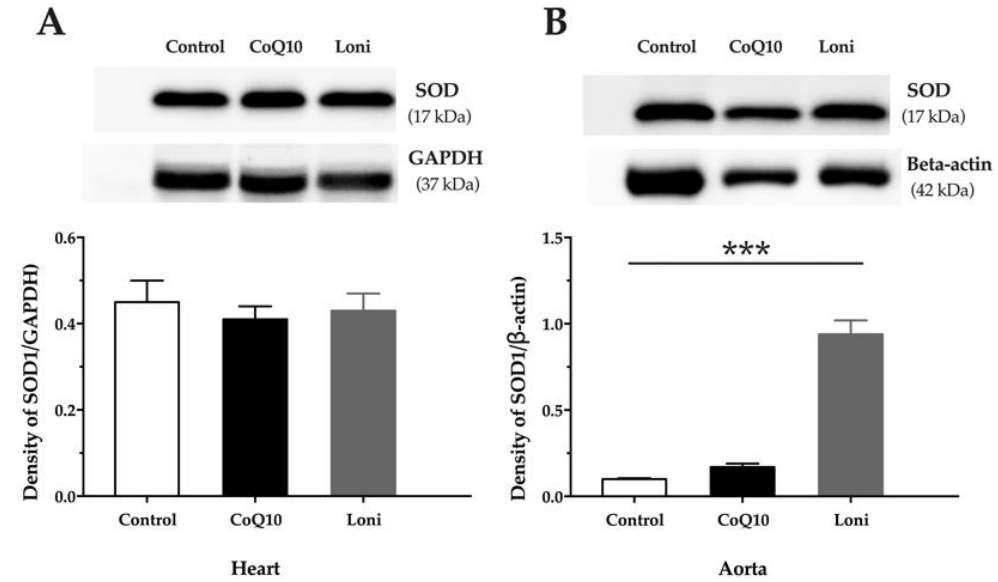
Figure 3. SOD1 protein expression in the heart ( A ) and aorta ( B ). CoQ10; coenzyme Q10, Loni; Lonicera caerulea L. Heart; F (2.15) = 0.25449, p = 0.77859; aorta; F (2.15) = 85.812, p = 0.00000. *** p < 0.001 compared to the control group. Data are means ± SEM from 6 animals in each group.